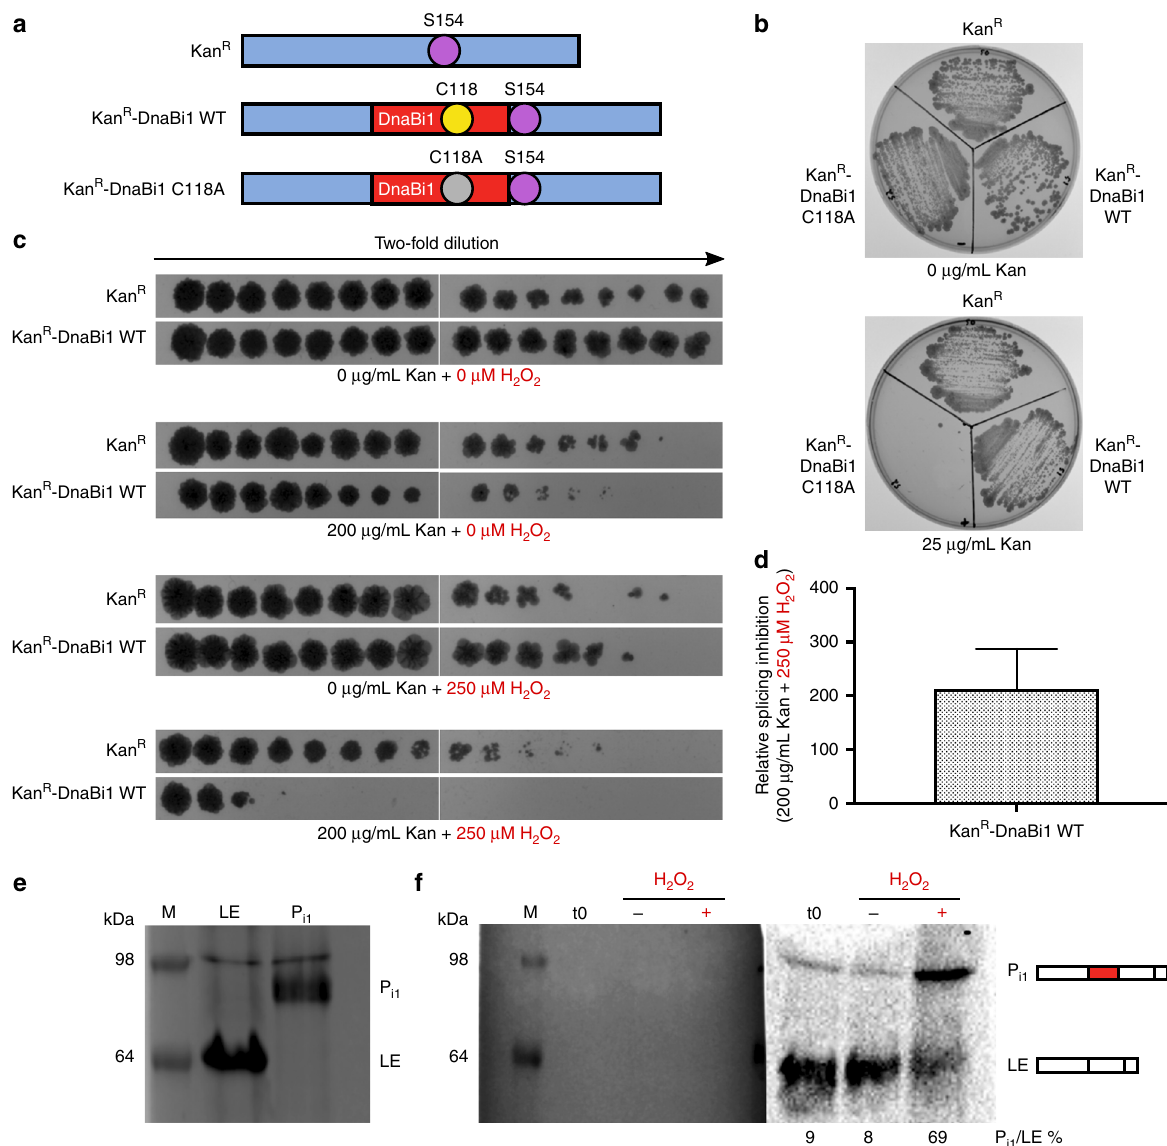
Fig. 4 DnaBi1 splicing is inhibited by H 2 O 2 in M. smegmatis . a Overview of “ Splice or Die ” constructs. Kanamycin-resistance protein was left uninterrupted (Kan R ) or interrupted with either an active DnaBi1 (Kan R -DnaBi1 WT) or inactive DnaBi1 with a C118A mutation (Kan R -DnaBi1 C118A). The Kan R Ser154 serves as the + 1 nucleophile for DnaBi1 splicing. b DnaBi1 splicing is required to confer resistance to kanamycin in Kan R -DnaBi1 fusion. M. smegmatis with Kan R , Kan R -DnaBi1 WT, or Kan R -DnaBi1 C118A (splicing inactive) were spread onto media with either 0 (top) or 25 (bottom) µ g/mL kanamycin. Biological replicates ( n = 4) were performed under similar conditions. c Survival of M. smegmatis expressing the Kan R -DnaBi1 fusion is selectively decreased compared to uninterrupted Kan R in the presence of kanamycin and H 2 O 2 . Two-fold dilutions of early log cells, shown covering a range from ~3 × 10 − 1 to ~9.2 × 10 − 6 , were spotted onto media with varying concentrations of kanamycin and H 2 O 2 , indicated below. Each experiment consisted of one culture for each strain. Biological replicates ( n = 3) were performed under similar conditions. d Quantitation of the relative splicing inhibition of Kan R -DnaBi1 WT in the presence of kanamycin and H 2 O 2 . The relative splicing inhibition of Kan R -DnaBi1 WT was found to be a 213.3-fold effect. Data are representative of biological replicates ( n = 3) and are expressed as mean ± s.d. e Migration pattern of DnaB ligated exteins and P i1 precursor. Overexpressed DnaB ligated exteins, P i1 precursor, and a prestained ladder as a size marker (M) were separated by SDS-PAGE and stained by Coomassie. The apparent higher molecular weight of products compared to Fig. 2c is a result of different buffers between the experiments. f Western blot analysis shows DnaB P i1 precursor accumulates following H 2 O 2 treatment in M. smegmatis . Stationary phase cells (t0) were diluted tenfold in fresh media without (H 2 O 2 , − ) or with 5 mM H 2 O 2 (H 2 O 2 , + ) and grown for 1 h. Left, Western blot membrane with prestained ladder post-transfer. Right, chemiluminescence detection of DnaB ligated extein and P i1 precursor products, using an anti-DnaB extein 1 antibody. Biological replicates ( n = 3) were performed under similar